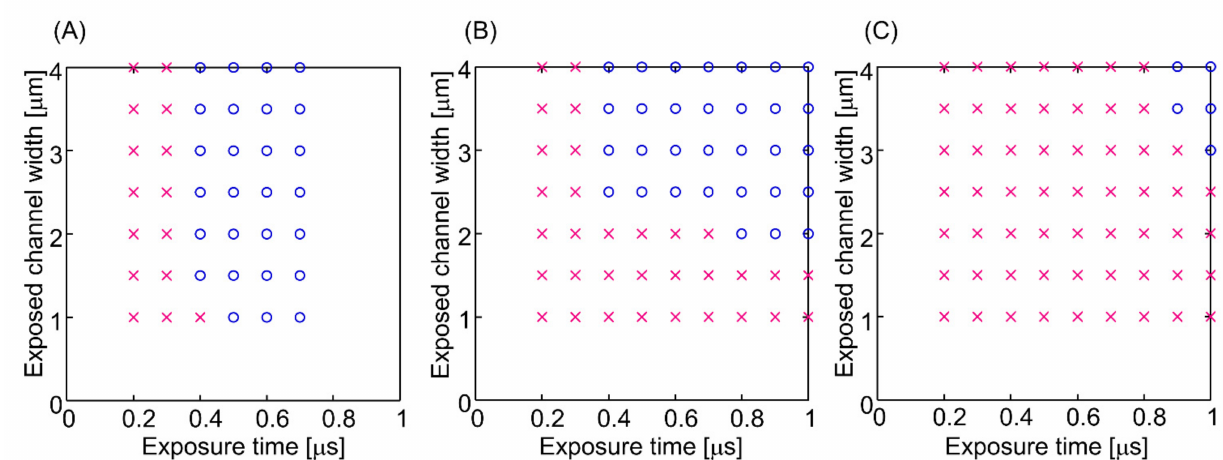
Figure 4. Relationship between exposure time and exposed channel width. Circles indicate conditions for successful channel fabrication, cross marks indicate conditions for failed channel fabrication. ZEP-520A EB resist with thicknesses of ( A ) 1700 nm, ( B ) 1900 nm, and ( C ) 2300